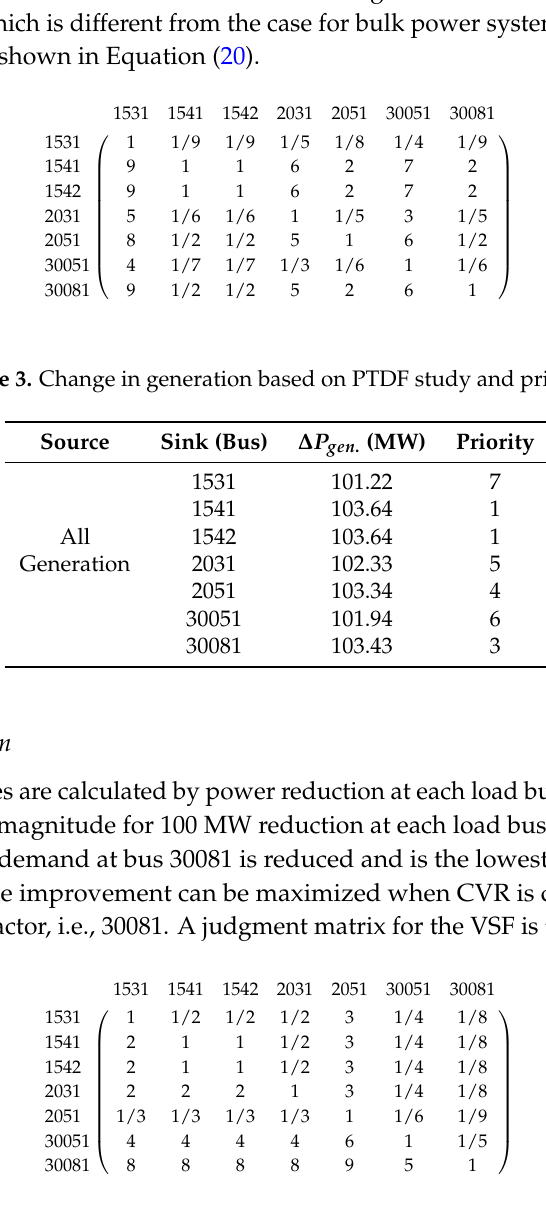
Table 4. Average value of VSF and